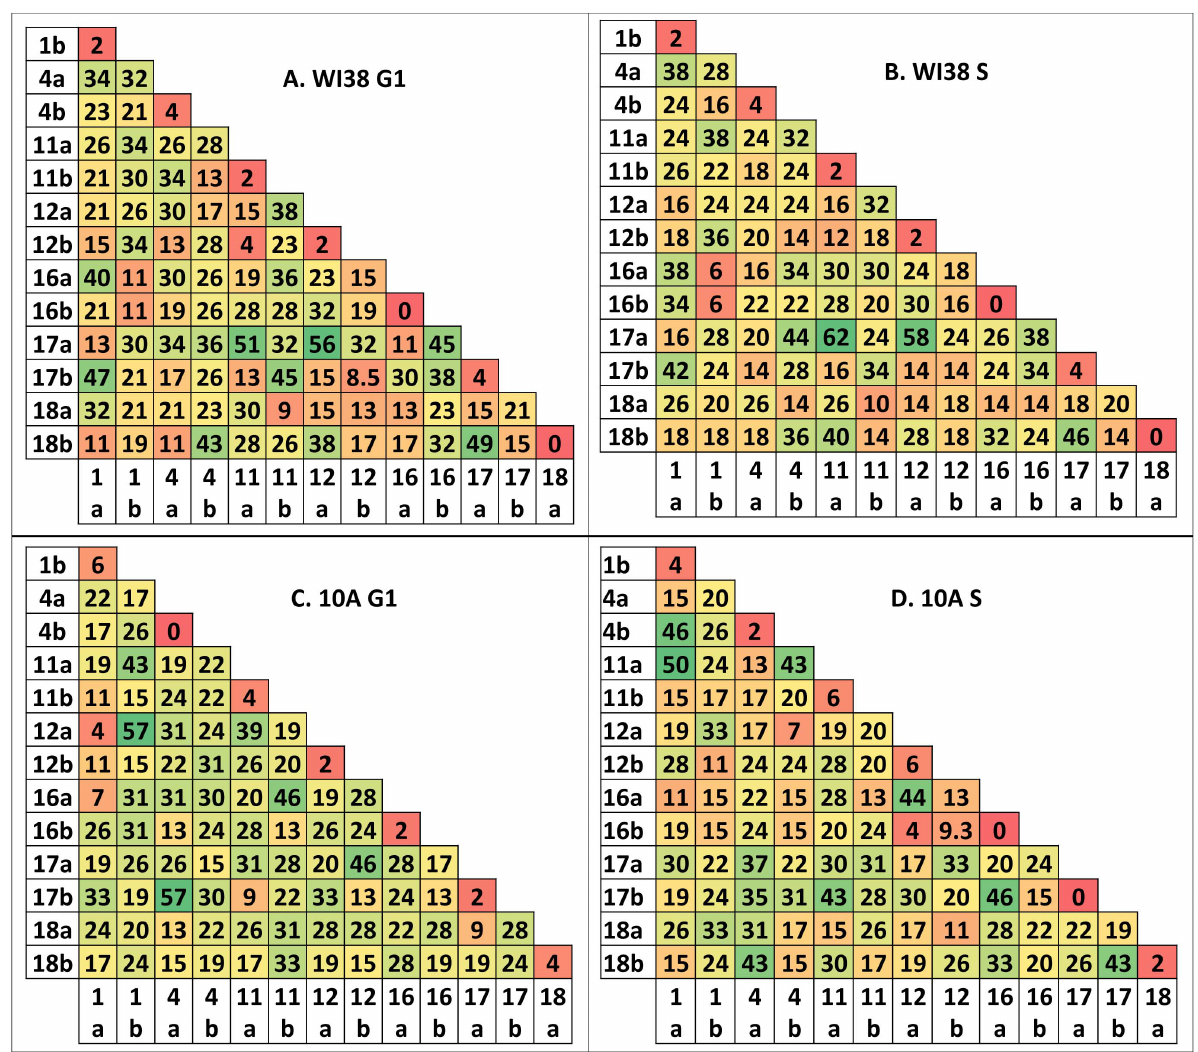
Figure 5. Chromatic median analysis of chromosome interactions in the cell cycle of WI38 and 10A. The chromatic median algorithm determines correspondence between homologs across nuclei based upon their interactions with other CT. This algorithm determined a median matrix for CT interactions in WI38 ( A–B ) and 10A ( C–D ) in G1 ( A, C ) and S phase ( B,D ). Each cell in the matrix represents the percent of input nuclei that have an interaction between those homologs. The values are color coded on a colorscale from low (red) to high (green).